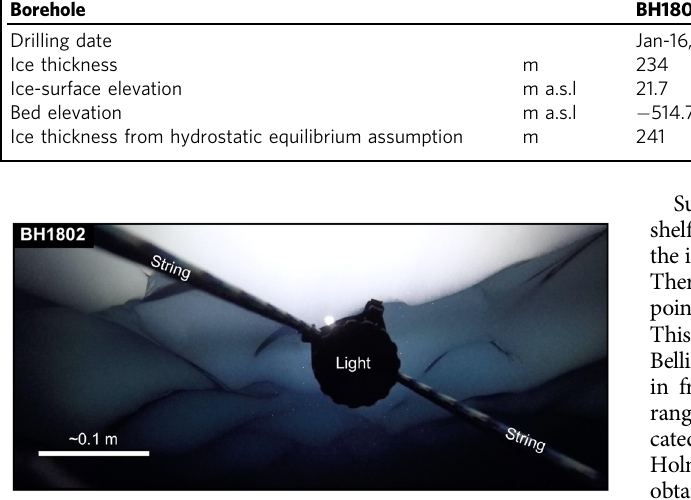
Table 1 Summary of ice and bed geometries at the drilling sites. Borehole